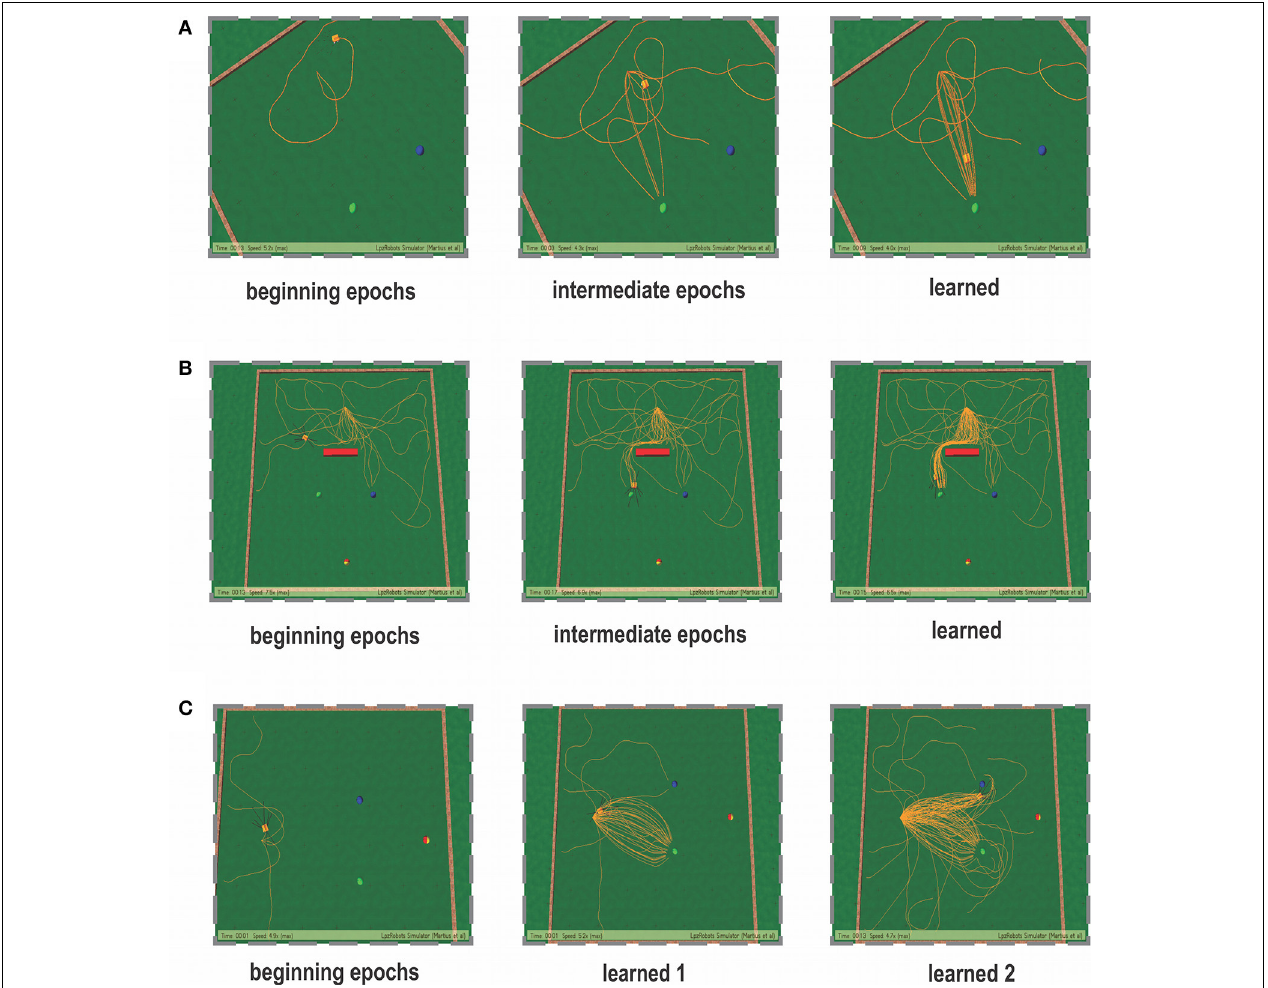
FIGURE 7 | Simulation snapshots of the robot learning for the three cases taken at specific epochs of time. (A) Snapshots of the learning behavior for the static foraging task without obstacles. (B) Snapshots of the learning behavior for the static foraging task with a single obstacle. (C) Snapshots of the learning behavior for the dynamic foraging task. Panel